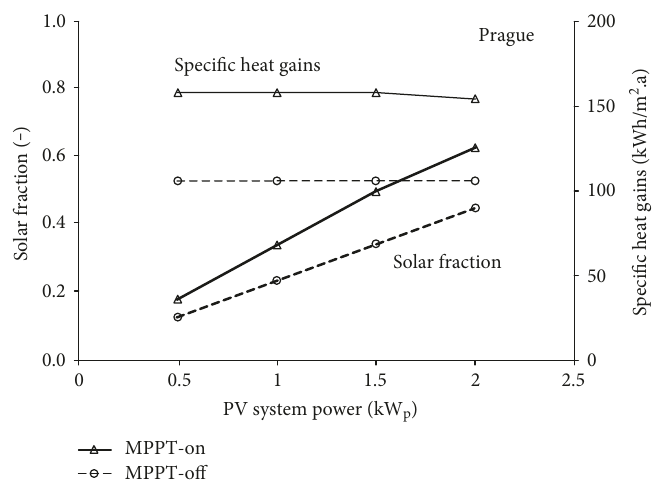
Figure 6: Performance characteristics of solar PV hot water system in the climate of